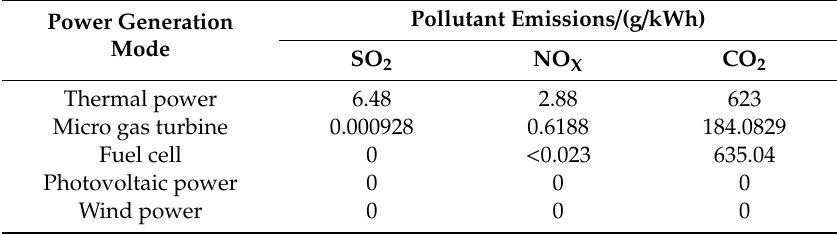
Table 1. Pollutant emission data of various power generation